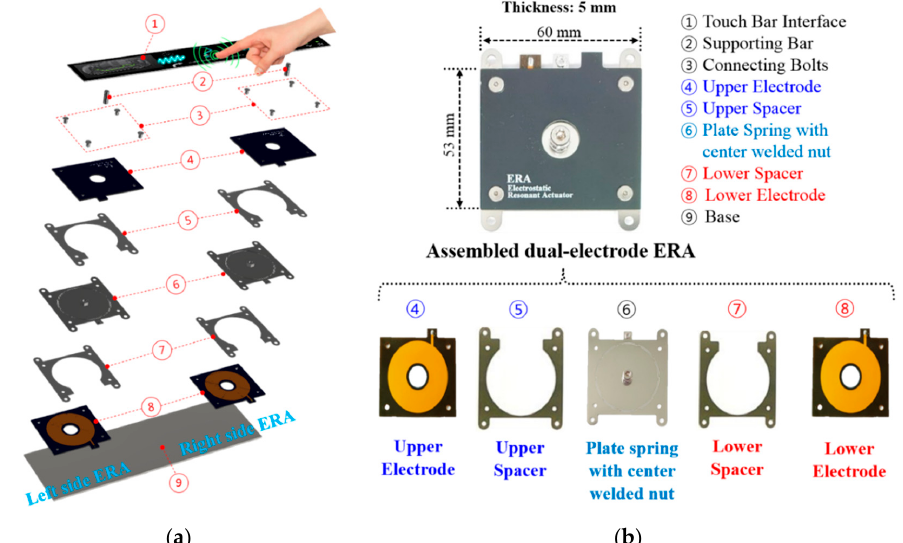
Figure 1. Haptic touch bar interface based on dual-electrode ERA: ( a ) An exploded perspective view of the touch bar interface design consisting of two dual-electrode ERAs and a long, narrow touch display; ( b ) assembled dual-electrode ERA and its components.